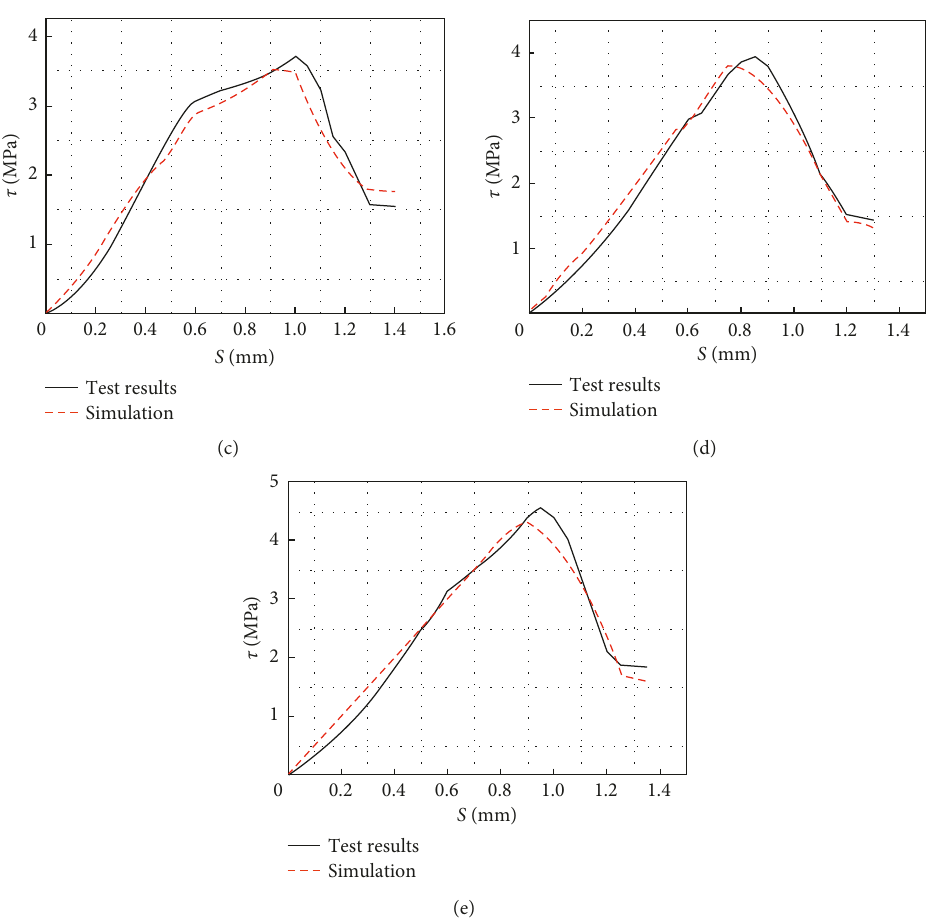
Figure 9: Comparison of simulation results and test results. (a) D90-L90. (b) D90-L135. (c) D90-L180. (d) D80-L120. (e)